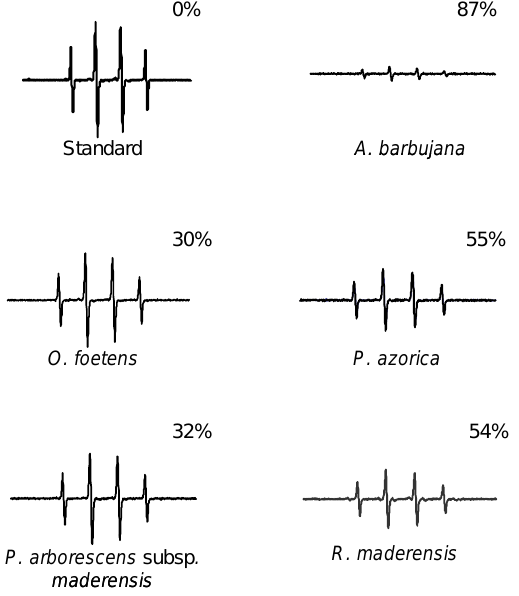
Figure 3. Effect of the water:ethanol extracts of the five Macaronesia plants under study on the EPR spectra, as described in the section 3.5. The percentage represents the relative attenuation of the EPR signal amplitude relative to that of the